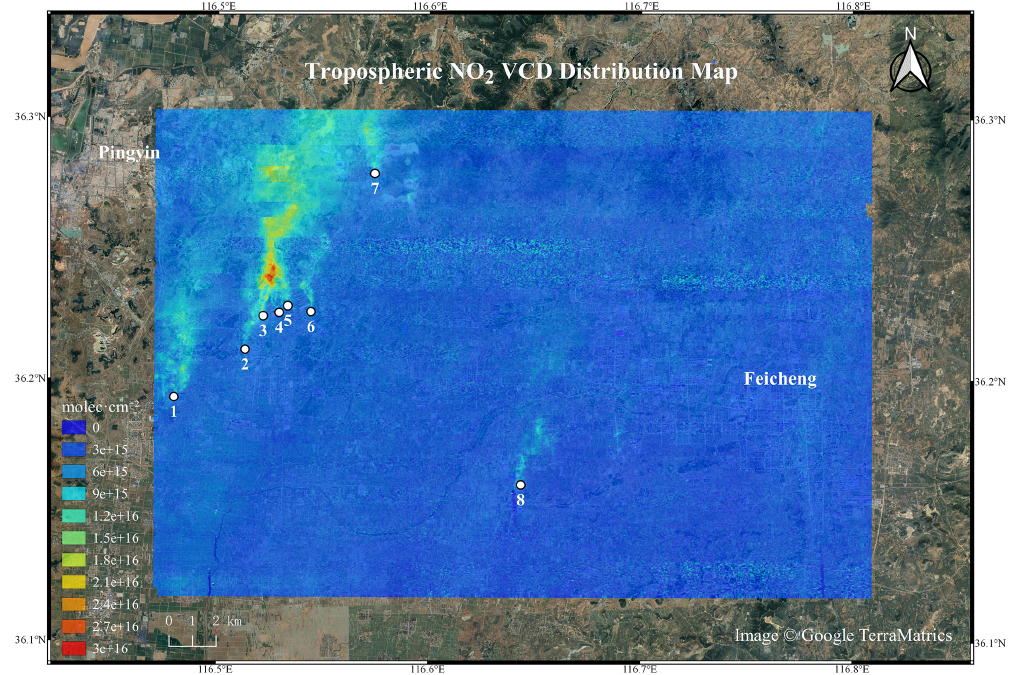
Figure 10. Tropospheric NO 2 VCD map retrieved from UVHIS over Feicheng on 23 June 2018. The major contributing NO x emission sources are indicated by numbers 1 to